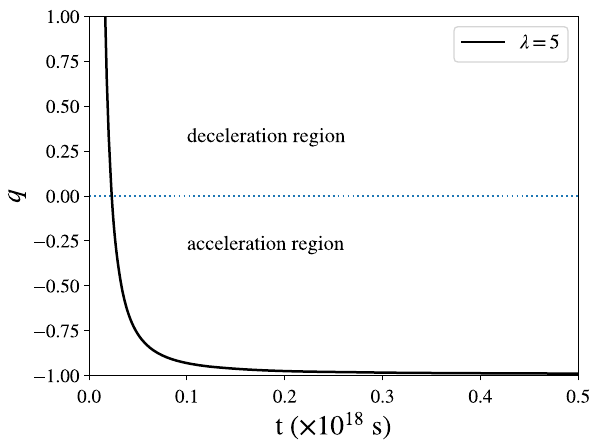
Fig. 1 Evolution of the deceleration parameter with time. A change of signal on q is presented, therefore, the theory, for f ( R , T ) = R + λ T 2 , predicts a transition between a decelerated Universe to an accelerated one, without the need for dark